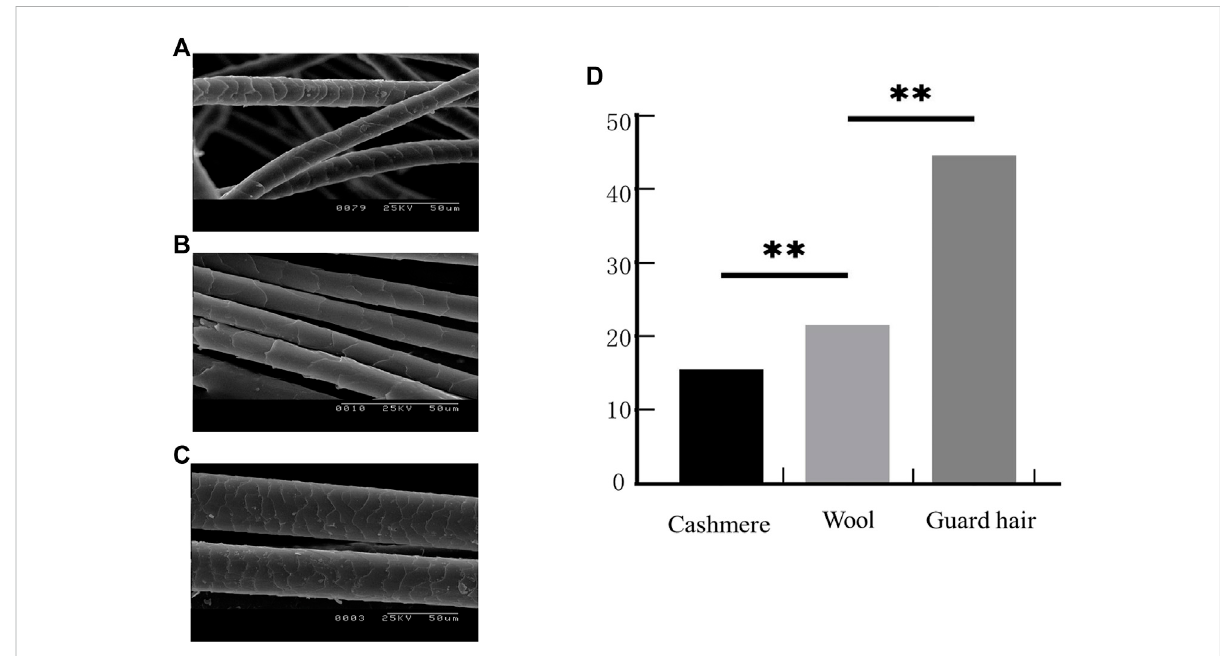
Fiber phenotypic traits. (A) . Sheep fi ber scale structure. (B) . Cashmere fi ber scale structure. (C) . Goat fi ber scale structure. (D) . Three types of fi ber fi neness values (T test: ** p < 0.01).